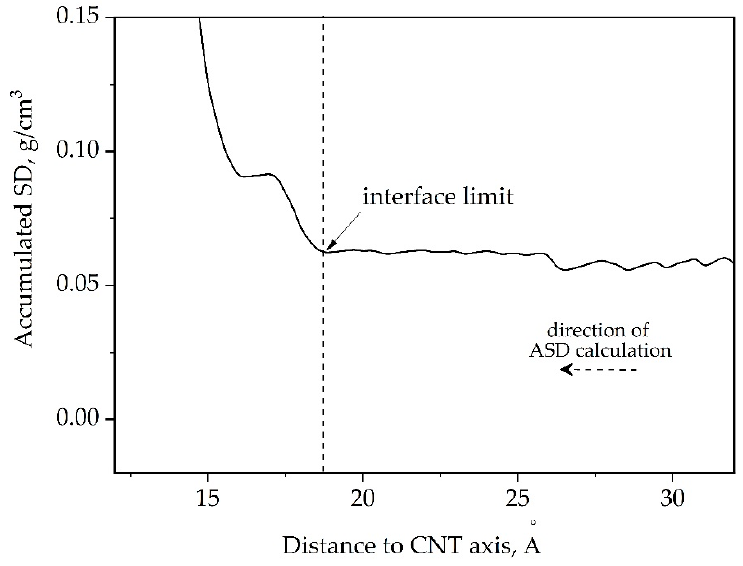
Figure 6. Example of the accumulated standard deviation (ASD) curve calculated from the polymer density profile (obtained from model 1b).